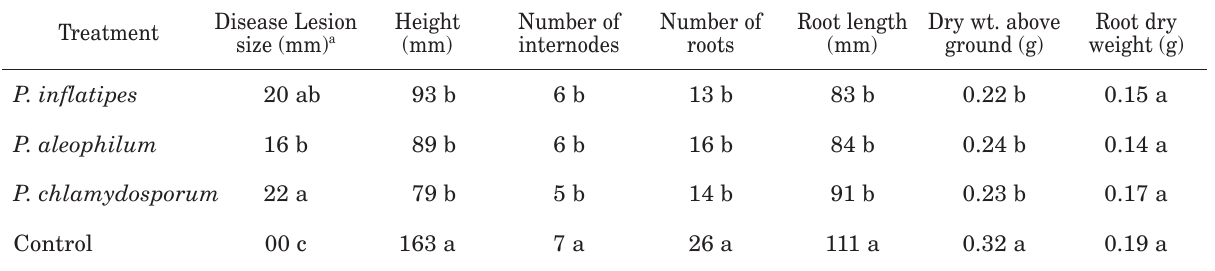
Table 3. Effect of Phaeoacremonium inflatipes P. aleophilum and P. chlamydosporum on plant height, number of internodes, number of roots, root length, dry weight of above ground parts and dry weight of roots in inoculated grapevine